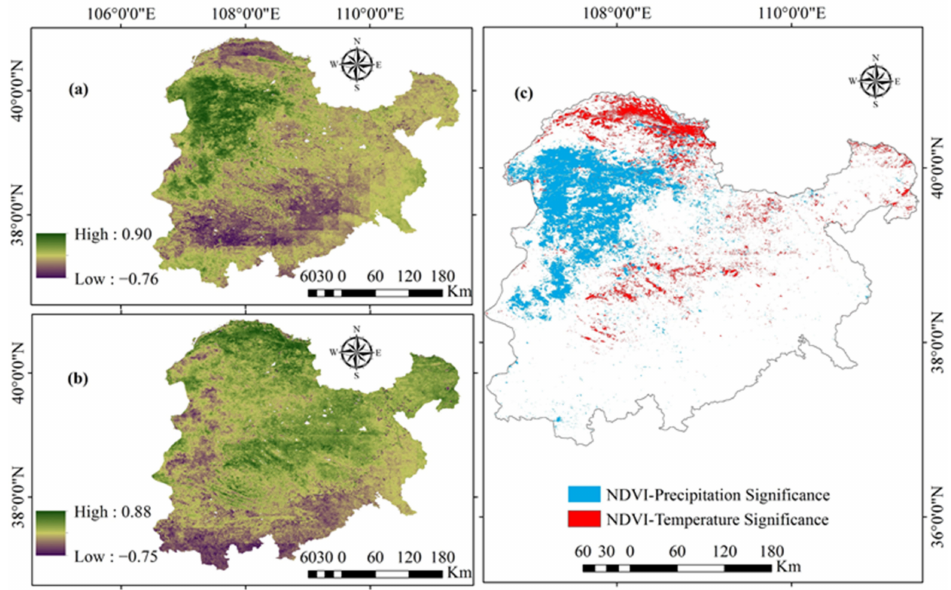
Figure 5. ( a ) NDVI -Precipitation Correlation in MU US (2001–2018) ( b ) NDVI -Temperature Correla- tion in MU US (2001–2018) ( c ) NDVI Climatic Factors Significance (R > 0 & p < 0.05).